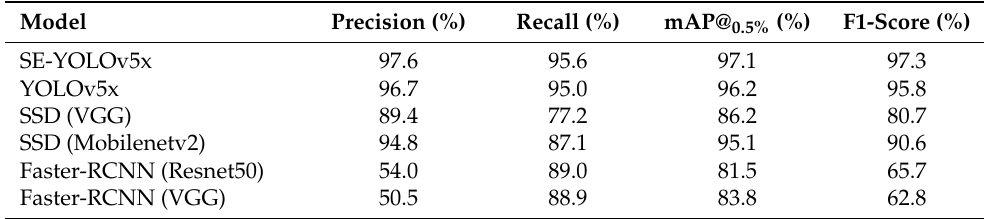
Table 1. Lettuce and weeds classification results of different deep learning models.